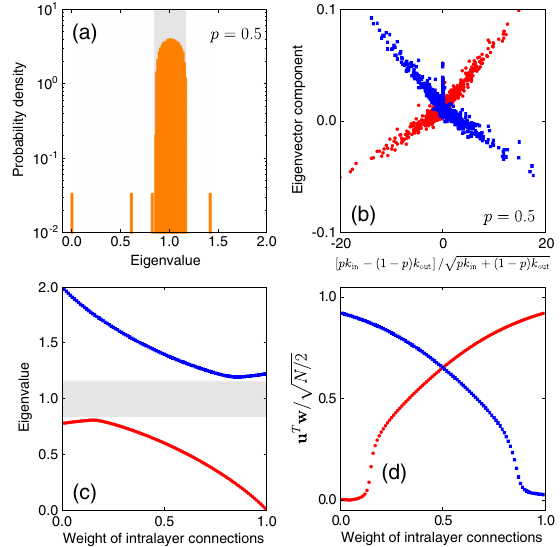
FIG. 3. Supercritical regime. Spectral analysis of the normal- ized Laplacian L for an interconnected network with a degree sequence identical to the one analyzed in Fig. 1. In this case, however, intra- and interlayer degree sequences are aligned in such a way that the correlation term is ξ ≃ 1 = 2 ðh k 2 i þ h k i 2 Þ . (a) For p ¼ 0 . 5 , the system is in the BD phase, where both the eigenvalues ν 2 and ν 2 N are well separated from the other eigenvalues of L . (b) The components of both eigenvectors w 2 and w 2 N are correlated with the right-hand side of Eq. (6). (c) The eigenvalues ν 2 (red circles) and ν 2 N (blue squares) touch the continuous band tangentially. (d) The order parameter clearly shows the presence of the supercritical regime, where both the B and D phases are simultaneously present, for a wide range of values of p . Only for very low (large) values of p , the system is in the pure B phase ( D